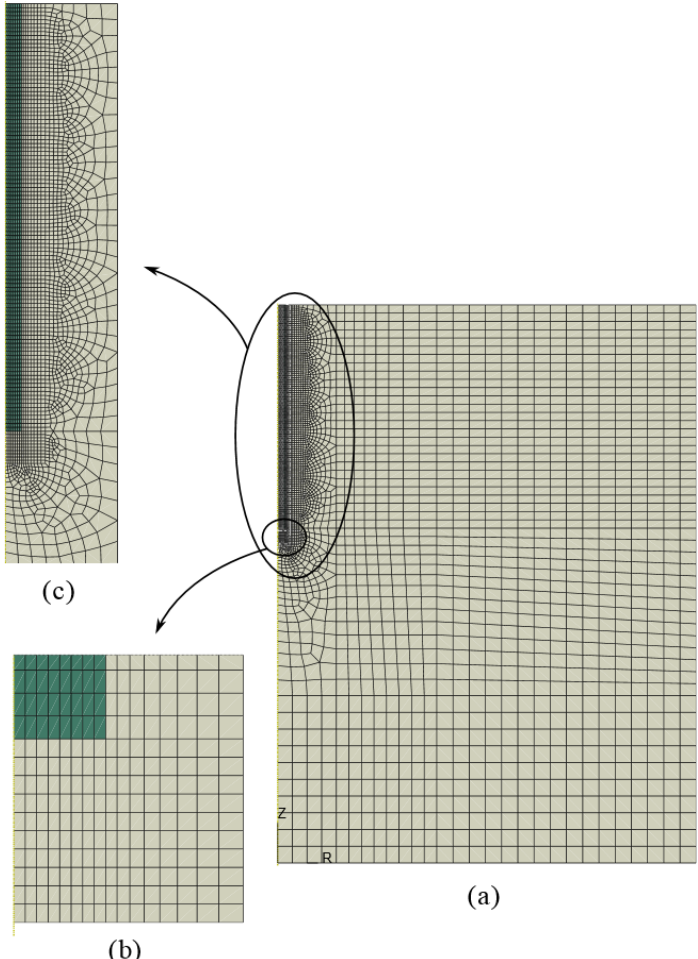
Figure 6. Finite element mesh used for model geometry (a), detailed mesh at pile tip (b) and detailed mesh at pile shaft (c).